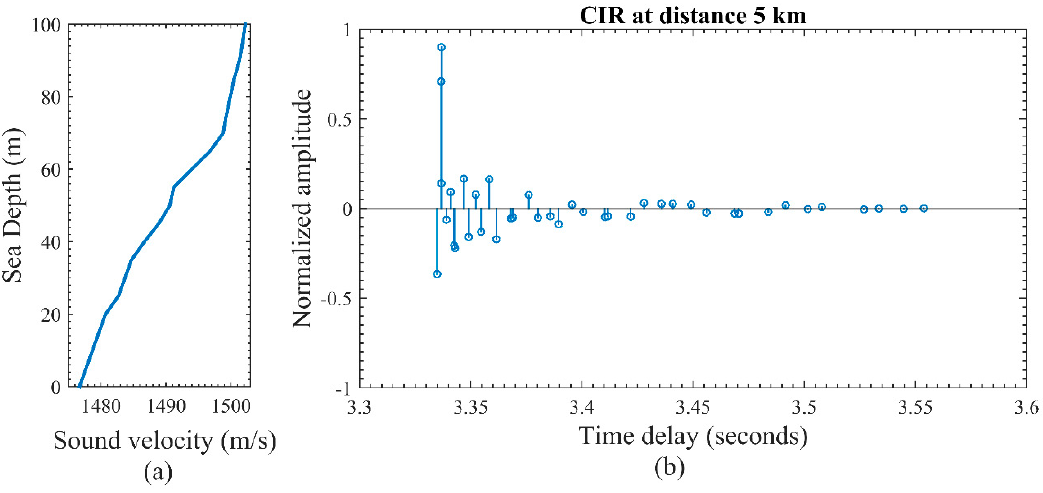
Figure 14. ( a ) Sound velocity profile of the channel. ( b ) Channel impulse response based on sound speed profile.